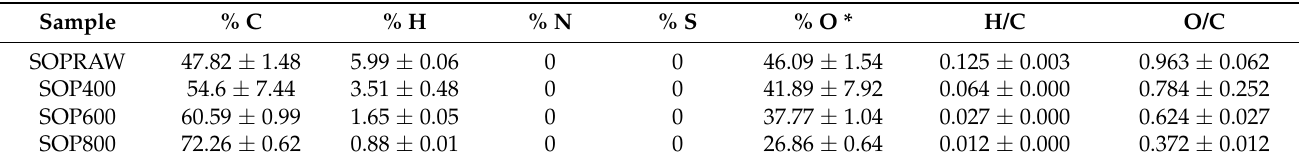
Table 2. Analysis of elemental composition (wt. % db) of SOPRAW and